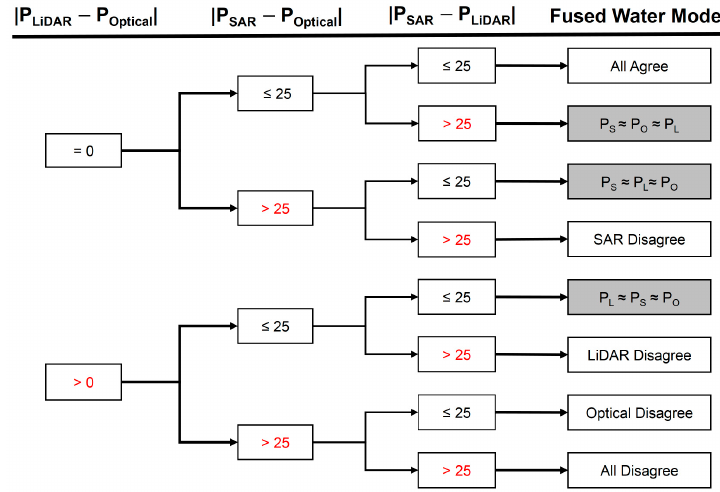
Figure 9. Decision tree classifier used to create five fused water models from each of the SAR water masks combined with the LiDAR and optical water masks. The absolute differences at the pixel value of each water mask (P S , P L and P O ) were calculated, and used to create eight different outcomes of which five occurred (white) and three did not occur (grey).